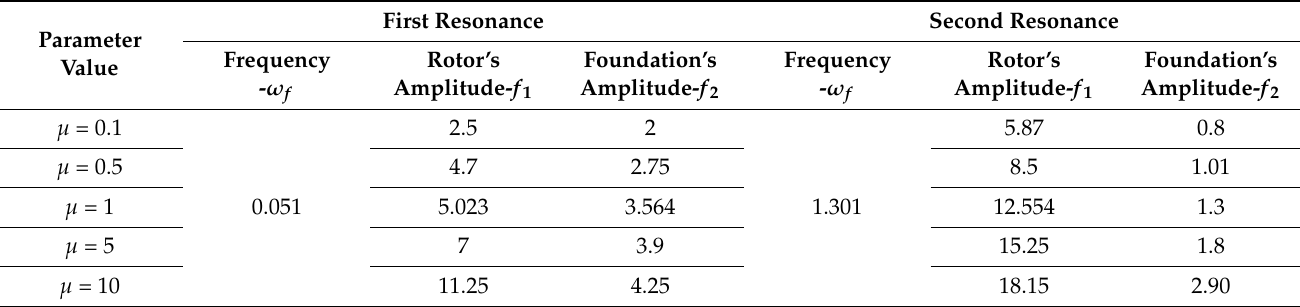
Table 5. Amplitudes and resonant frequencies for different mass